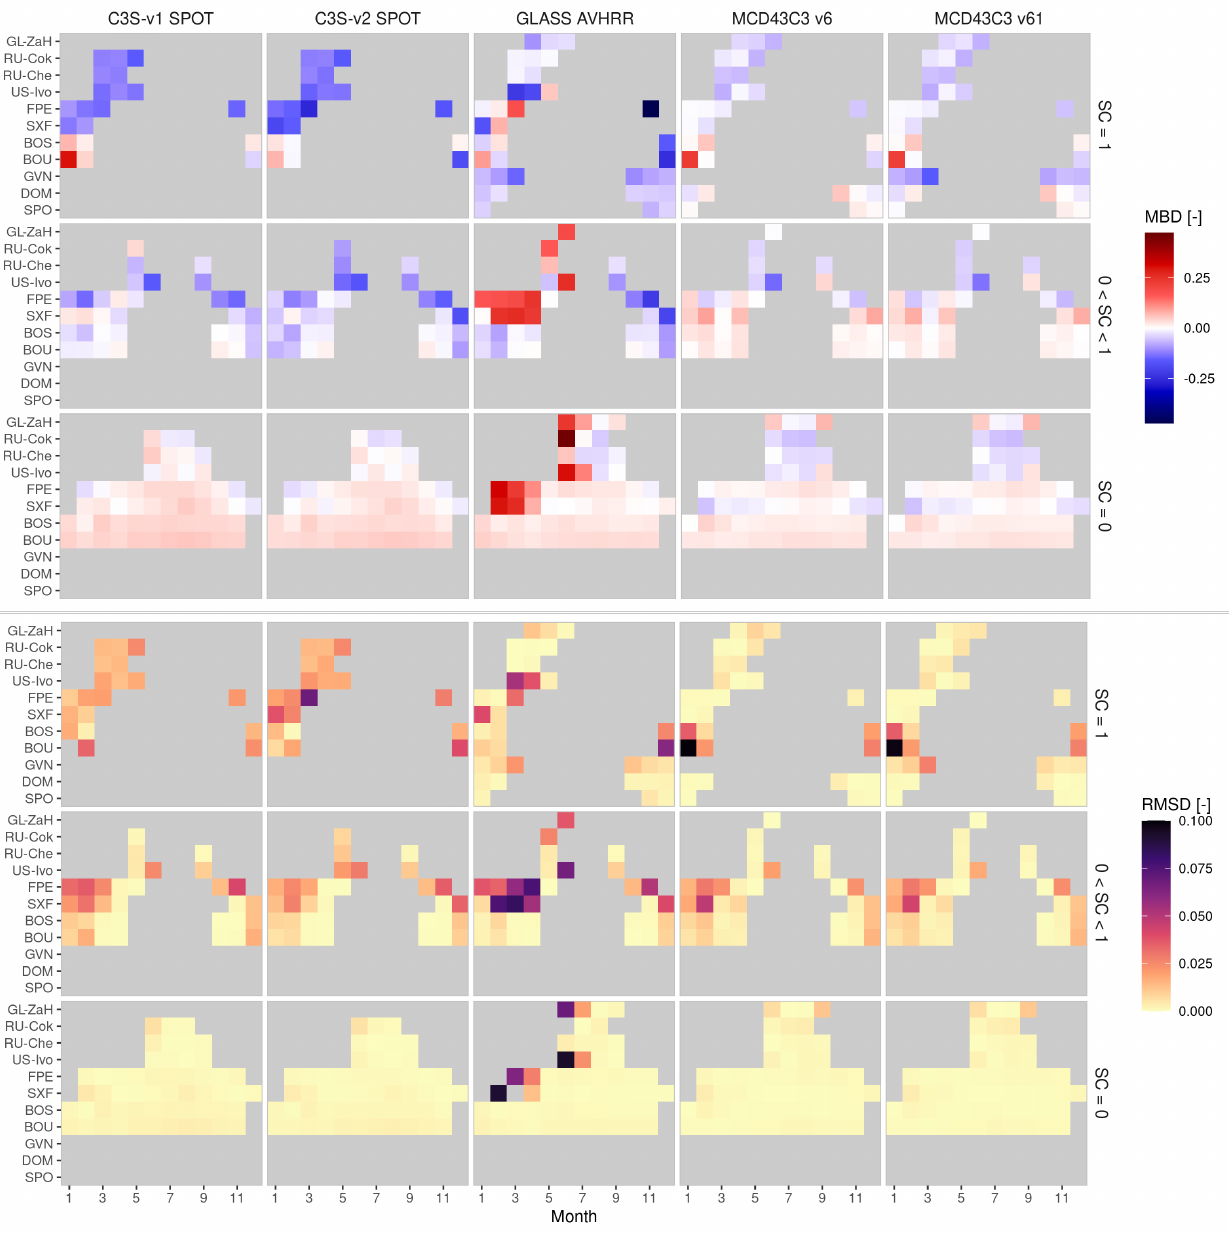
Figure 6. Monthly variation of mean bias deviation (MBD) and root mean squared deviation (RMSD) of monthly blue-sky albedo estimations for different snow cover conditions from 2000/02 to 2014/05. Stations are sorted top–down by decreasing